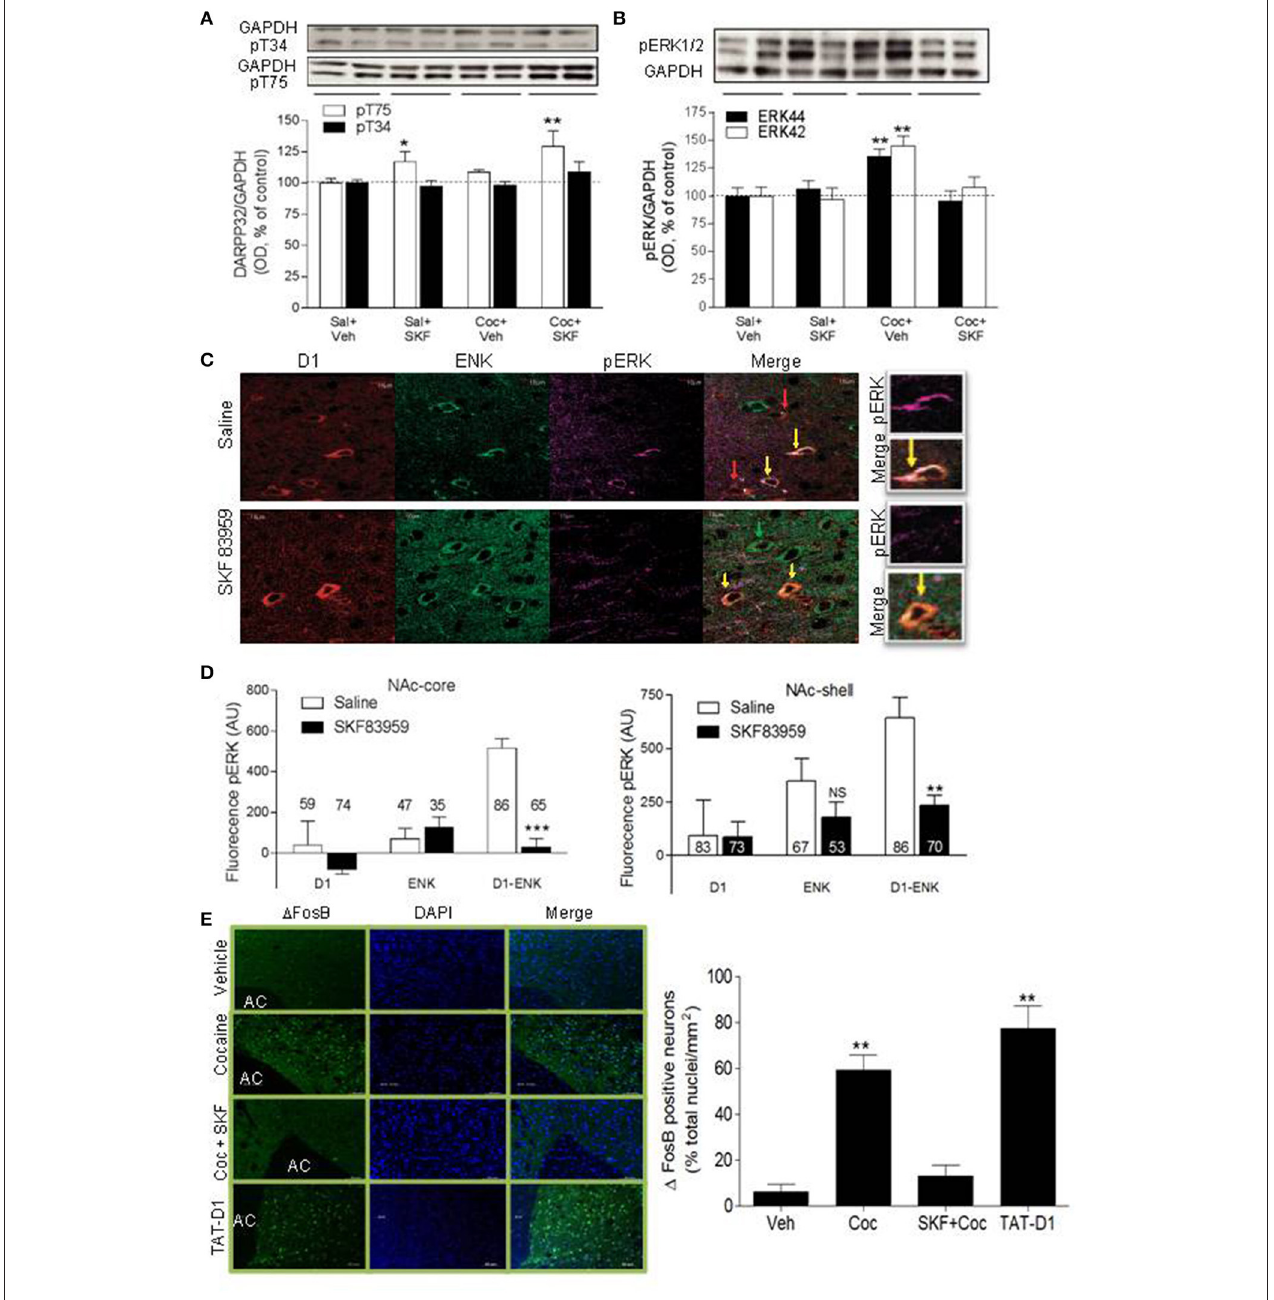
FIGURE 5 | Signaling pathways involved in D1-D2 heteromer modulation of cocaine-induced behaviors: DARPP-32, ERK and 1 FosB. (A) Representative immunoblots of pT34-DARPP-32 (top panel) or pT75-DARPP-32 (lower panel) obtained from NAc of rats conditioned with saline or cocaine (10 mg/kg, i.p.) and injected on the test day with saline or SKF 83959. Loading controls (GAPDH) are shown. Quantification of pT34- and pT75-DARPP-32 immunoblots is shown. (B) Representative immunoblot of pERK44/42 obtained from the NAc of rats conditioned as in (A) is shown. Quantification of pERK44/42 immunoblots obtained from all animals is shown. Results in (A,B) represent the mean ± SEM from 8 to 9 rats/condition. * p < 0.05 and ** p < 0.01 represent significant differences from control. (C) Representative confocal images of pERK assessed in the three types of MSNs: D1R-only (red arrow), Enk-only (D2R, green arrow) or D1R and ENK (D1-D2 heteromer)-expressing neurons (yellow arrow) in MSNs from NAc of saline- or SKF 83959-treated rats. (D) Quantification of pERK fluorescence in MSNs in the NAc. Results are the mean ± SEM of data after removing the non-specific background ( n = number of MSNs from N = at least 3 rats/condition). (** p < 0.001; *** p < 0.0001). (E) Representative immunohistochemistry images and their quantification obtained using an antibody against 1 FosB and a secondary antibody conjugated to Alexa-488. Nuclei are stained by DAPI. Rats were treated for 7 days with cocaine (10 mg/kg, i.p.) without or with co-injection of SKF 83959 (1 mg/kg, s.c.). Disrupting the heteromer by repeated injections of TAT-D1 had the same effect as repeated injections of cocaine. Results are means ± SD obtained by the analysis of n = 1,500–1,700 neurons from the NAc of N = 3 rats/condition.